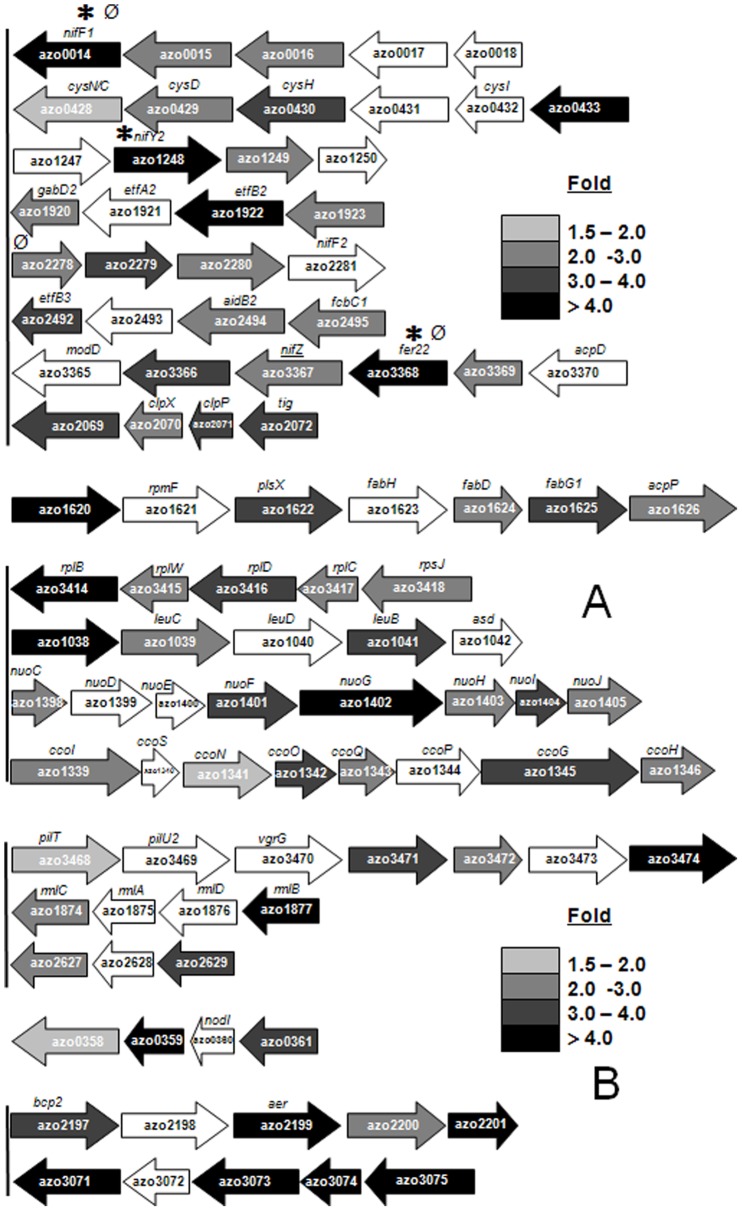
Gene clusters positively or negatively regulated in the presence of NifA under nitrogen fixing conditions.(A) Gene cluster(s) positively regulated by NifA and also up-regulated (upper), down-regulated (middle) or not modulated (lower) under N2 fixation. (B) Gene cluster(s) negatively regulated by NifA and also up-regulated (upper), down-regulated (middle) or not modulated (lower) under N2 fixation. Fold of induction of each gene is according to the gray shade code index provided. Blank arrows represent no detectable modulation of the target gene. Symbols ∗ or Ø represent predicted intergenic RpoN-binding sites or NifA-binding sites, respectively, upstream of the target gene of interest, as described in the legend of Figure 2.